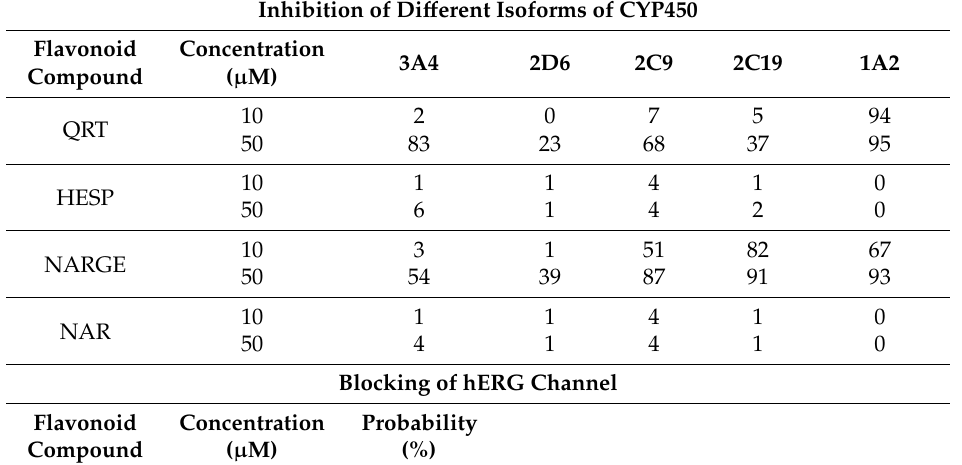
Table 3. In silico toxicity parameters calculated for all flavonoids. Inhibition of Di ff erent Isoforms of